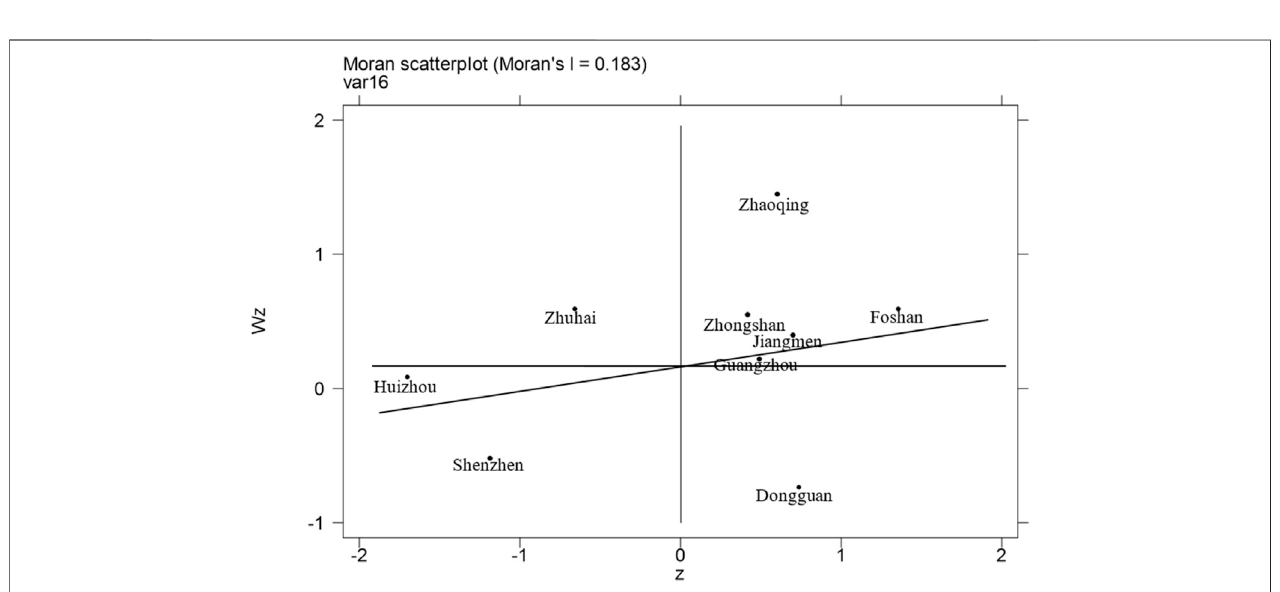
FIGURE 8 | Moran scatter plot of PM 2.5 in the Pearl River Delta region in